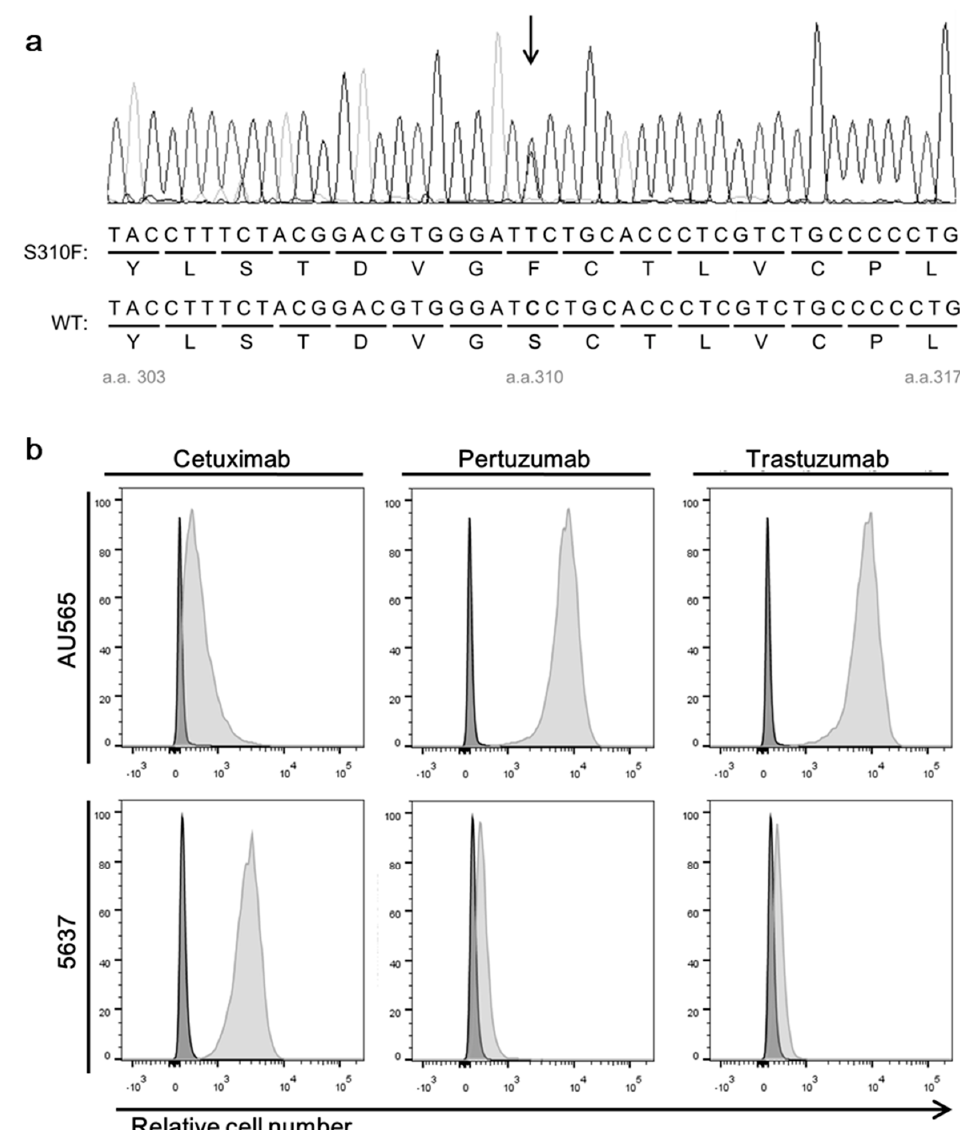
Figure 2. Expression of HER2 and epidermal growth factor receptor (EGFR) in 5637 and AU565 cells. ( a ) A representative sequence chromatogram showing the presence of two transcripts encoding wild-type HER2 and the S310F mutant in 5637 cells. ( b ) Flow cytometry analysis of two cancer cell lines assessing their reactivity to cetuximab, pertuzumab, and trastuzumab. The cells were incubated with individual antibody using the recombinant scFv-human C κ fusion protein. The amount of bound antibody was determined using Allophycocyanin (APC)-labeled anti-human C κ antibody.